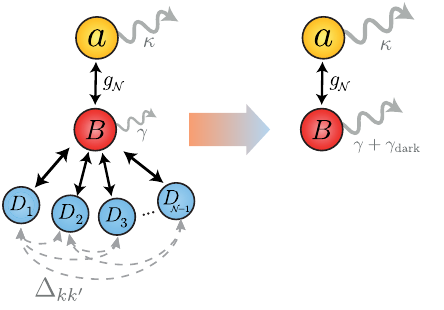
FIG. 10. In the case of disorder of the electronic transition fre- quencies, the dark modes are coupled to the bright mode and to each other while the bright mode couples to the cavity mode with rate g N . Elimination of the dark, cavity uncoupled modes then leads to an effective two hybridized mode problem (cavity mode and bright collective state) with renormalized loss